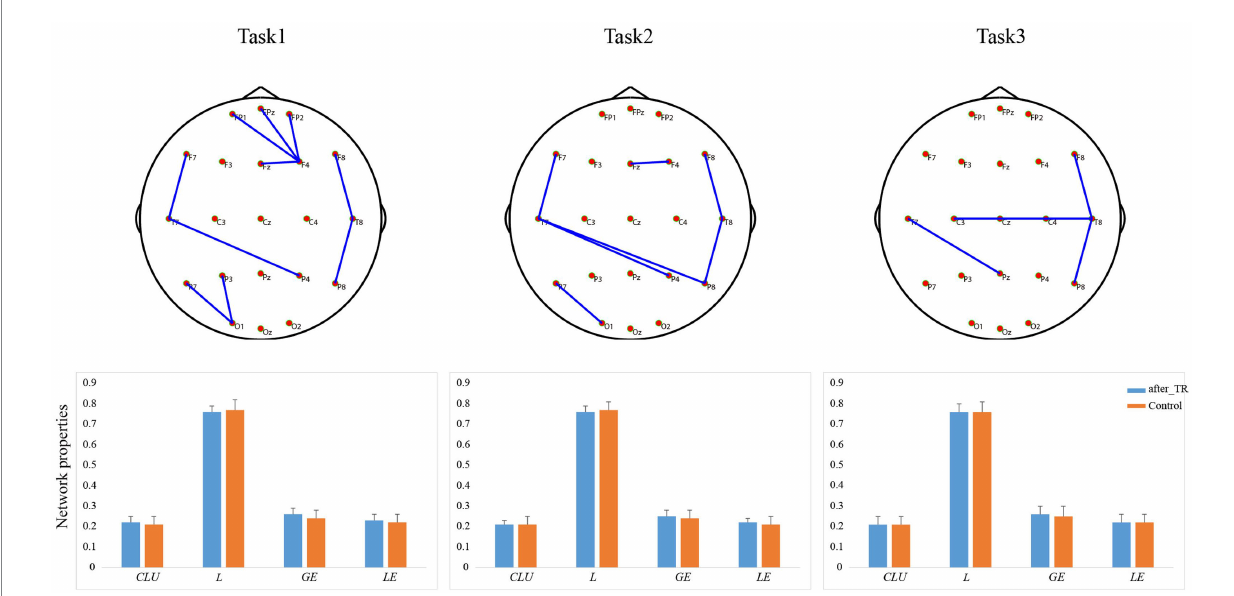
FIGURE 5 The first line is network topology differences between the after_TR group and the control group in the cool executive tasks (Task 1: THT; Task 2: TMT-A; Task 3: TMT-B). The corresponding network properties in the three tasks were below the network topologies. The blue solid lines denote the stronger network edges ( p < 0.05, FDR corrected) of the after_TR group compared to those of the control group.